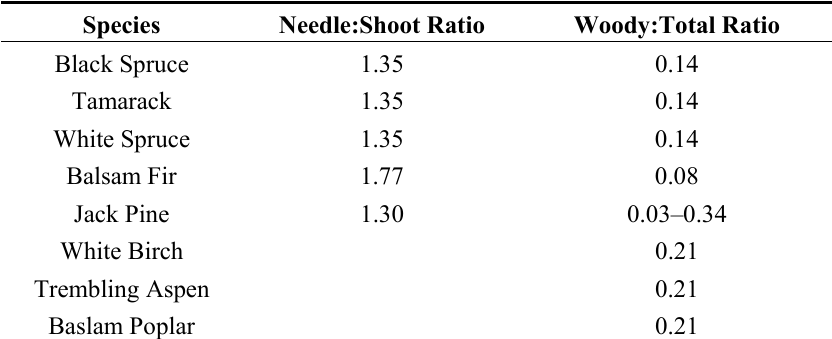
Table 2. Species TRACWin ratios. Species Needle:Shoot Ratio Woody:Total Ratio Black